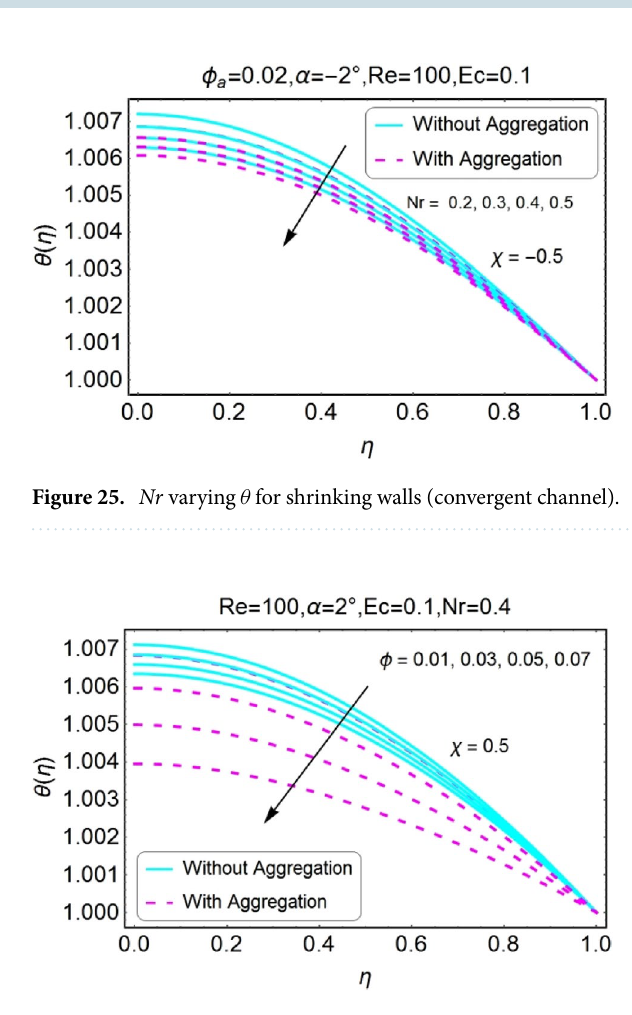
Figure 26. φ varying θ for stretching walls (divergent channel).